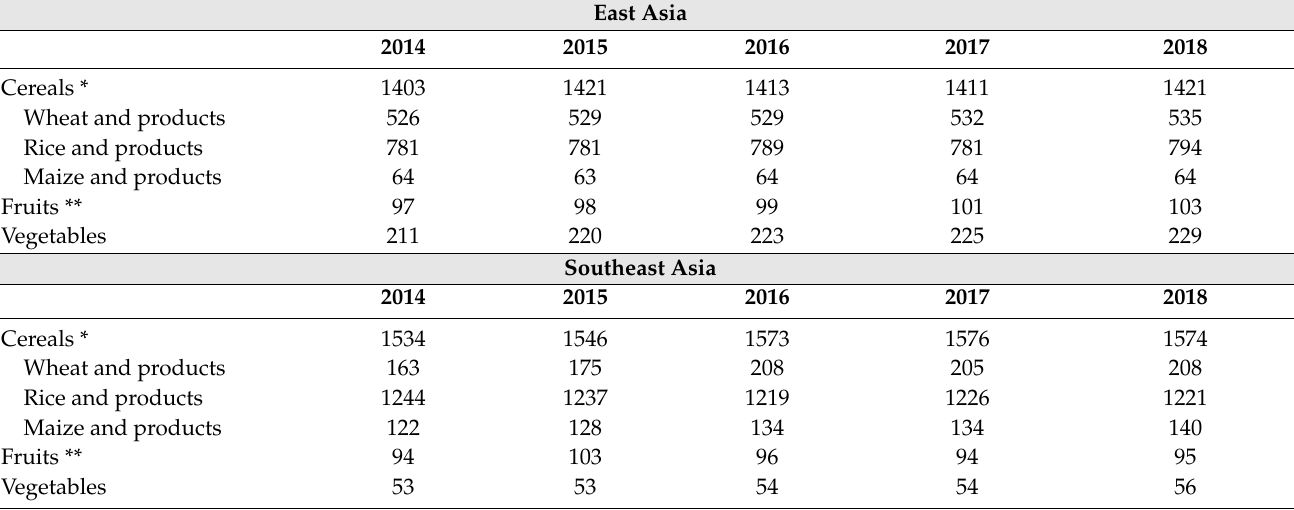
Table 7. Plant-based food available for consumption in East and Southeast Asia (kcal/capita/day).